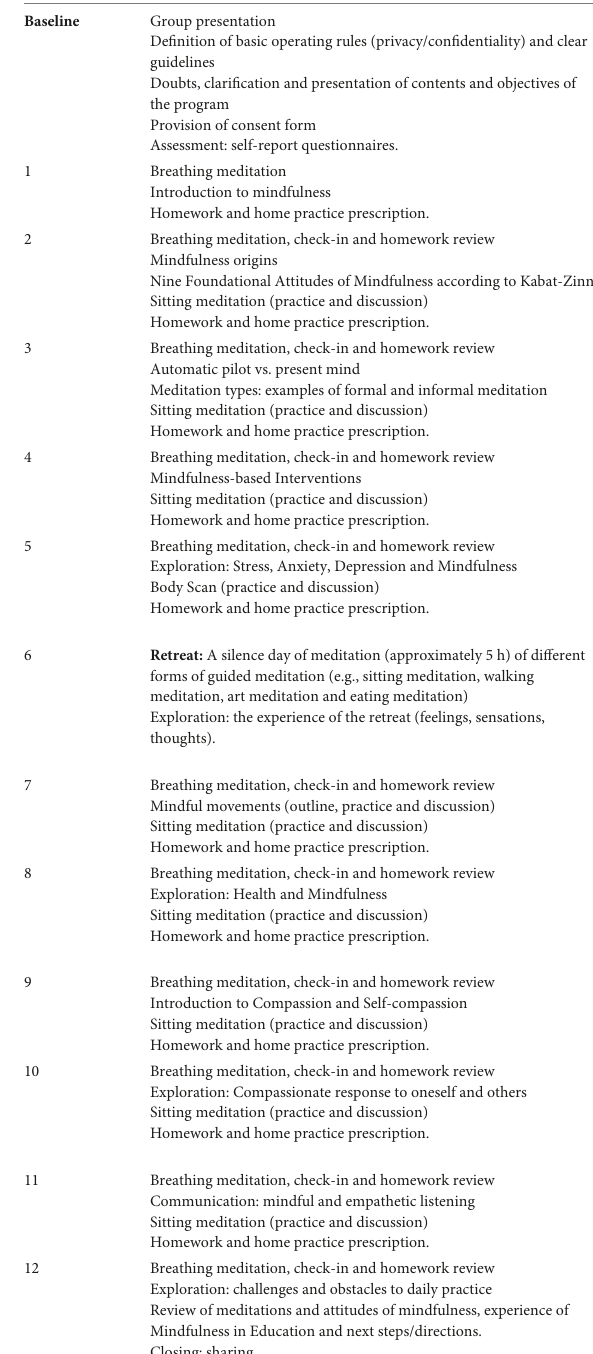
TABLE 2 Mindfulness in education